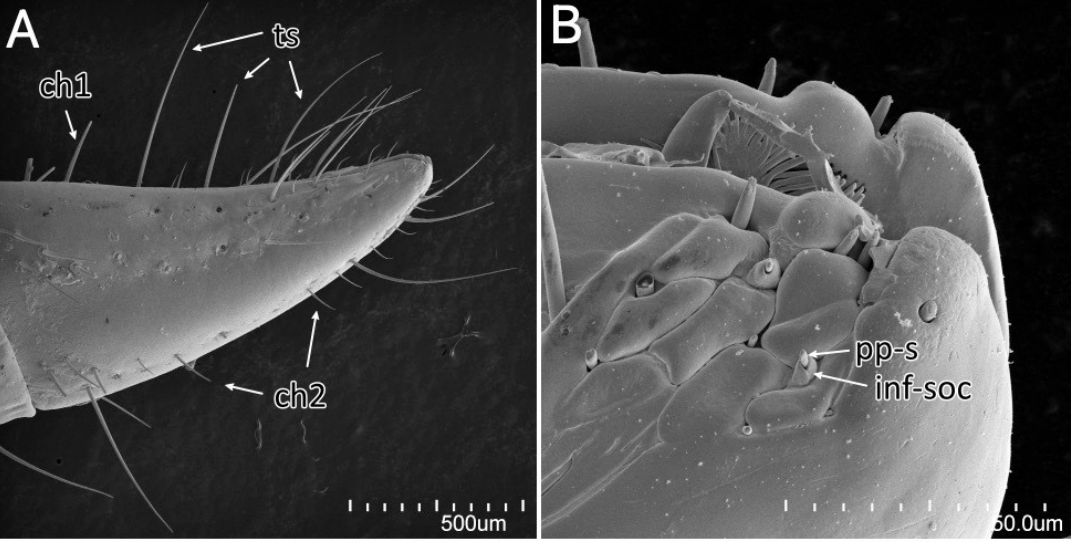
Figure 21. Psyttala horrida (Stål, 1865) third instar, SEM views. ( A ) Fourth visible labial segment with sensilla chaetica and trichodea ; ( B ) sensory field at the tip of the labium; ( C ) sensilla coeloconica on the distal part of the labium, right under the sensory field; ( D ) magnification of the single sensillum coeloconicum . ch1 — sensillum chaeticum type 1; ch2 — sensillum chaeticum type 2; inf-soc —inflexible socket; pps —porus peg sensillum; sc — sensillum coeloconicum ; ts — sensillum trichodeum .